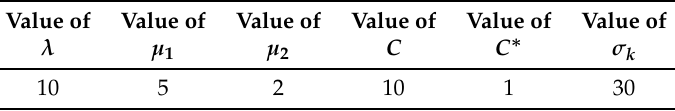
the developed algorithm